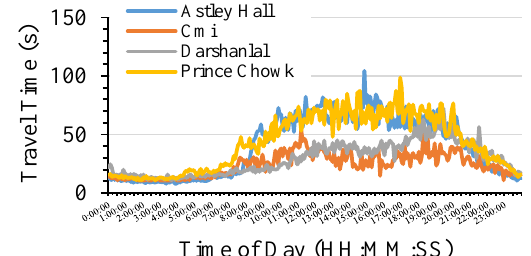
Figure 17. Variation in Travel Time at four junctions for full Day